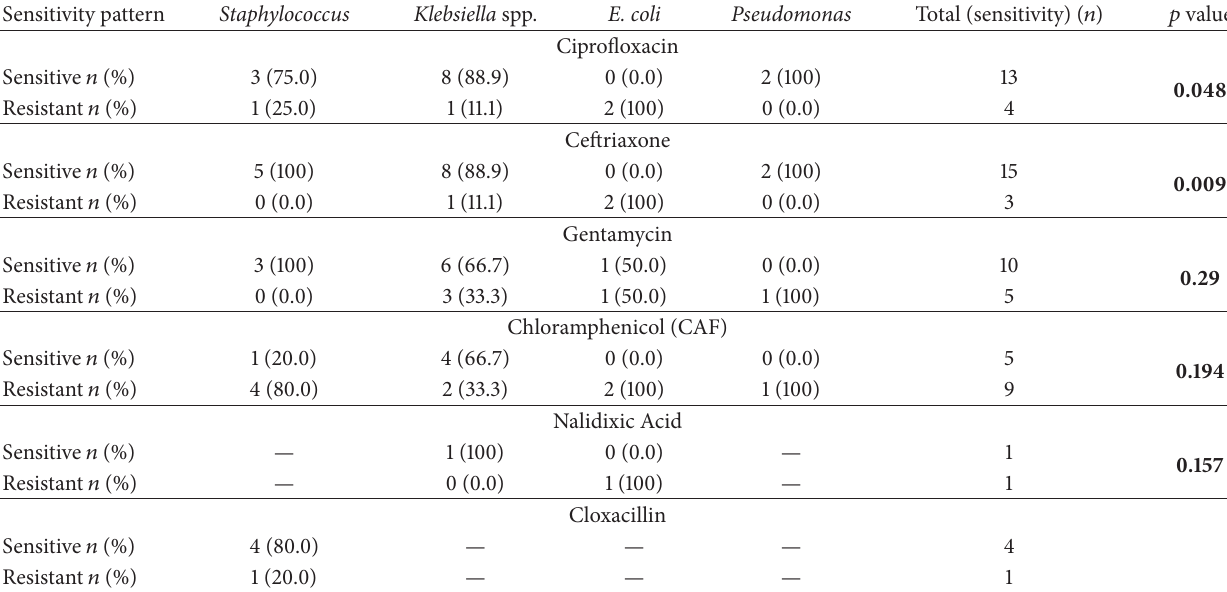
Table 4: Sensitivity patterns of the different organisms to the different